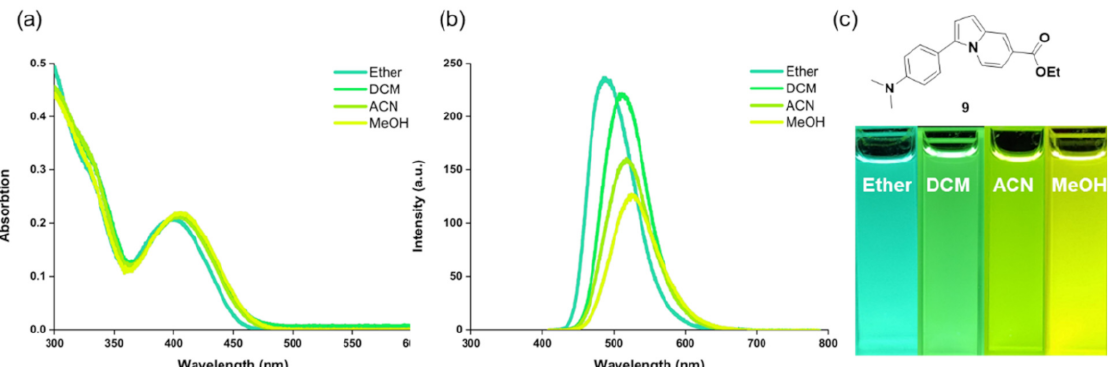
Figure 2. Solvatochromism of compound 9 . ( a ) Absorbance and ( b ) emission spectra of compound 9 in solvents with different polarity (diethyl ether, DCM, ACN, or MeOH). ( c ) Fluorescence photo image of compound 9 in different solvents taken under 365 nm UV light